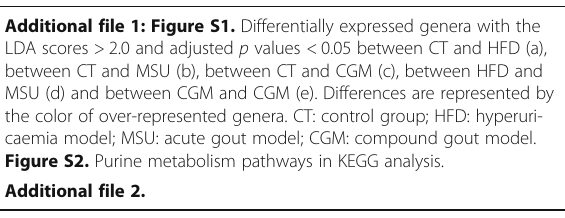
Figure S2. Purine metabolism pathways in KEGG